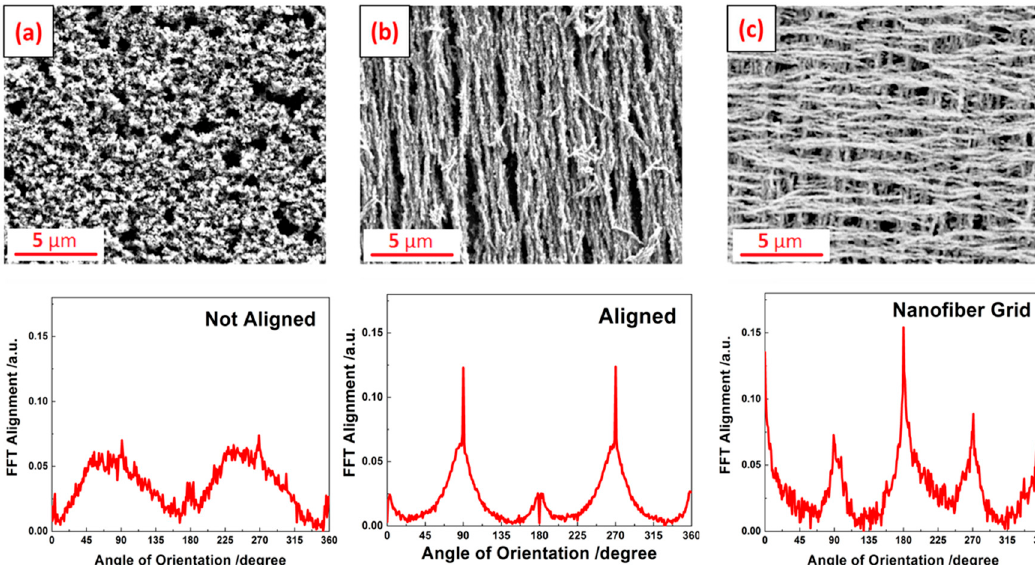
Figure 6. SEM images with corresponding 2D FFT alignment plots of two nickel layers sintered in ( a ) no magnetic field, ( b ) homogeneous magnetic field of 250 Oe in the same direction for all layers, and ( c ) multilayer printing and heating in presence of homogeneous magnetic field with alternating 0° and 90° orientations between layers.